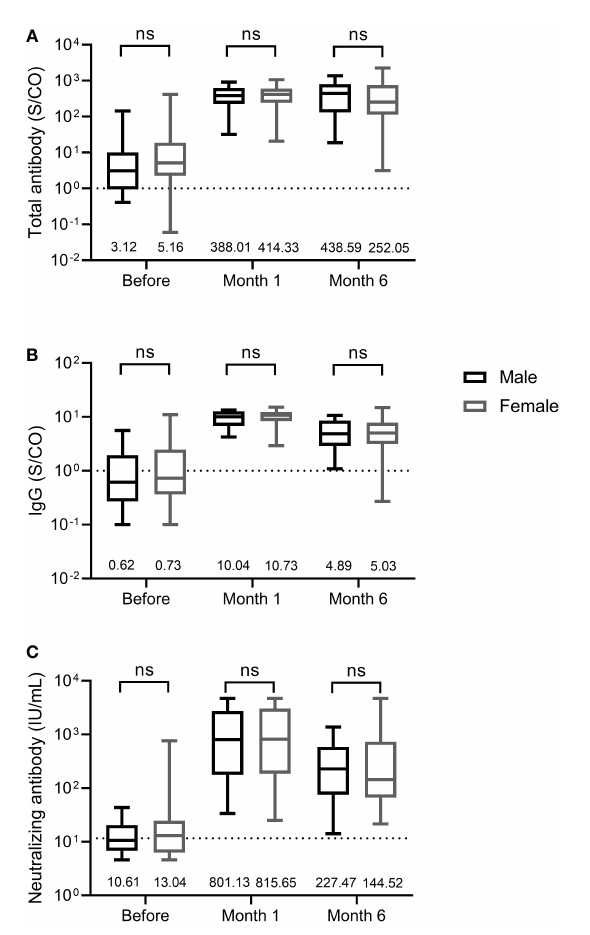
FIGURE 3 Antibody response induced by the third dose of homologous BBIBP- CorV inactivated vaccine in female and male participants. The levels of total antibody (A) and IgG antibody (B) against the receptor binding domain (RBD) of the SARS-CoV-2 spike (S) protein and neutralizing antibody (C) against SARS-CoV-2 are shown as the range (whiskers), interquartile range (boxes) and median (line within the boxes) values. The median levels of total antibody and IgG antibody against the RBD of the SARS-CoV-2 S protein and neutralizing antibody against SARS- CoV-2 are shown at the bottom of each panel. The dashed lines indicate the cut-off of total antibody and IgG antibody against the RBD of the SARS-CoV-2 S protein and neutralizing antibody against SARS- CoV-2. Comparisons were done by Mann-Whitney U test (A-C) . ns, not signi fi